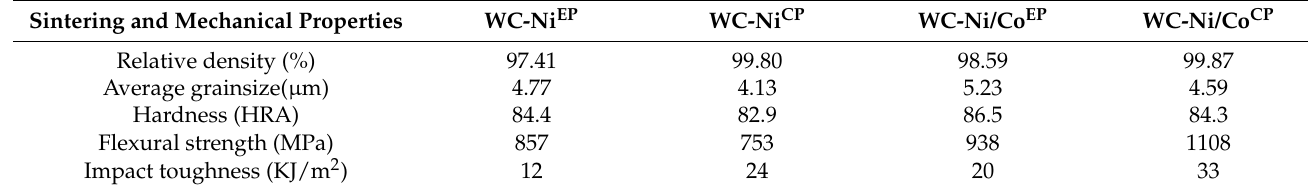
Table 3. Sintering and mechanical properties of cemented